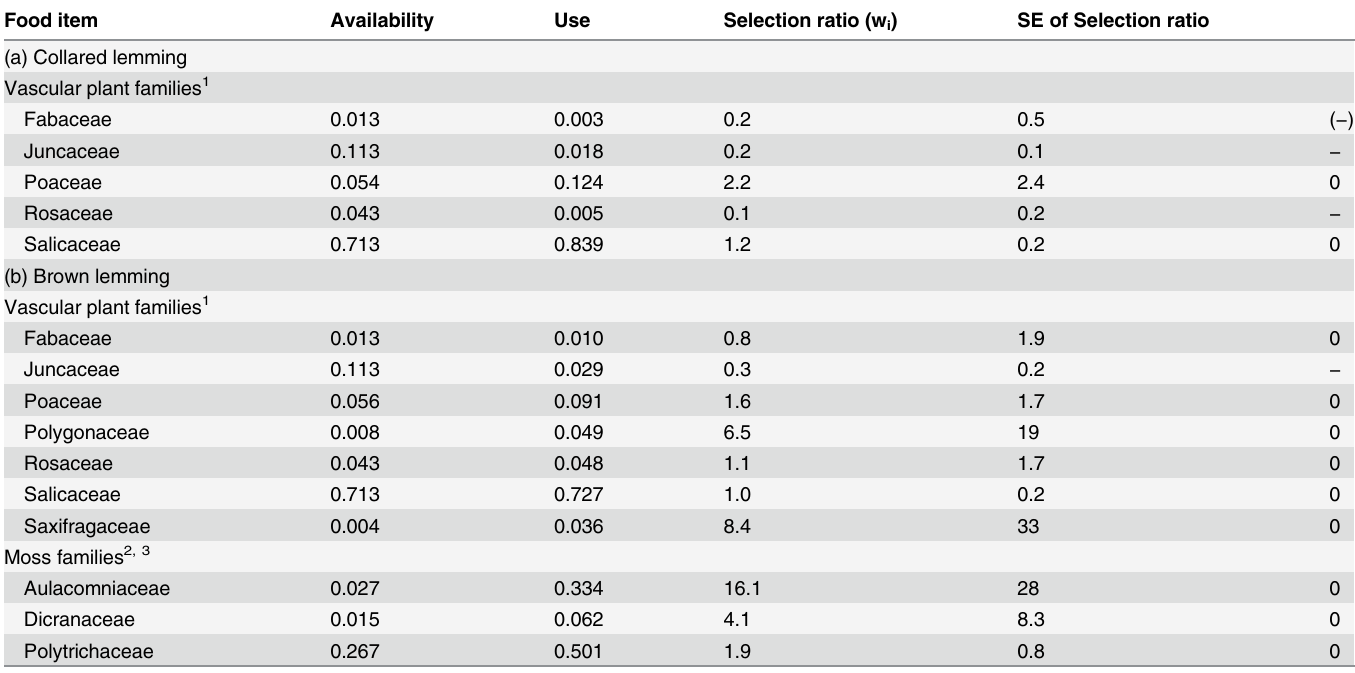
Table 2. Availability, use and selection of major food items ( > 1% of the diet) consumed by lemmings in winter. Food